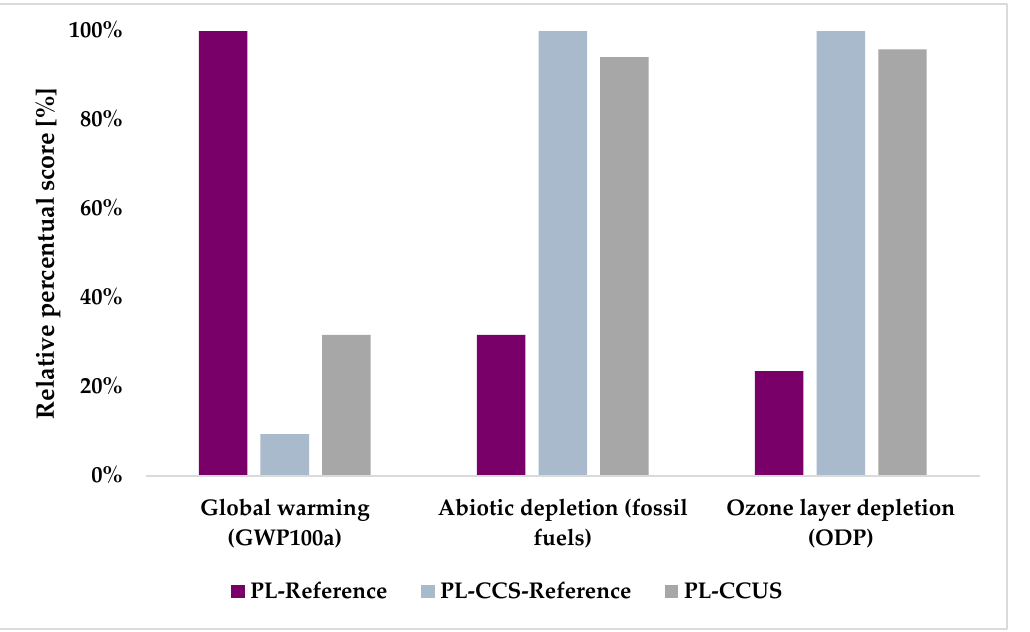
Figure 8. Impact category scores for the Polish case study in the CCUS scenario considering a comparable CCS reference scenario.